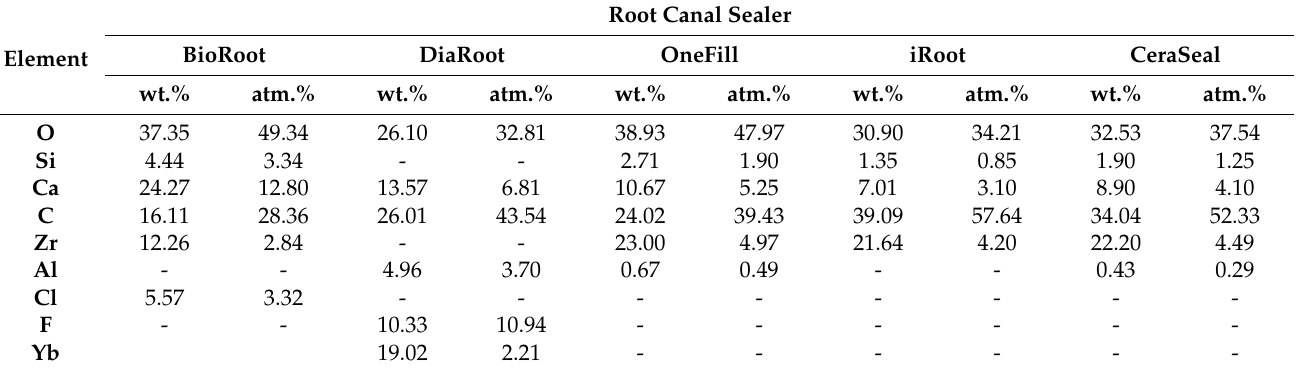
Table 2. Percentage of mass (weight %) of different elements presented among the tested root canal